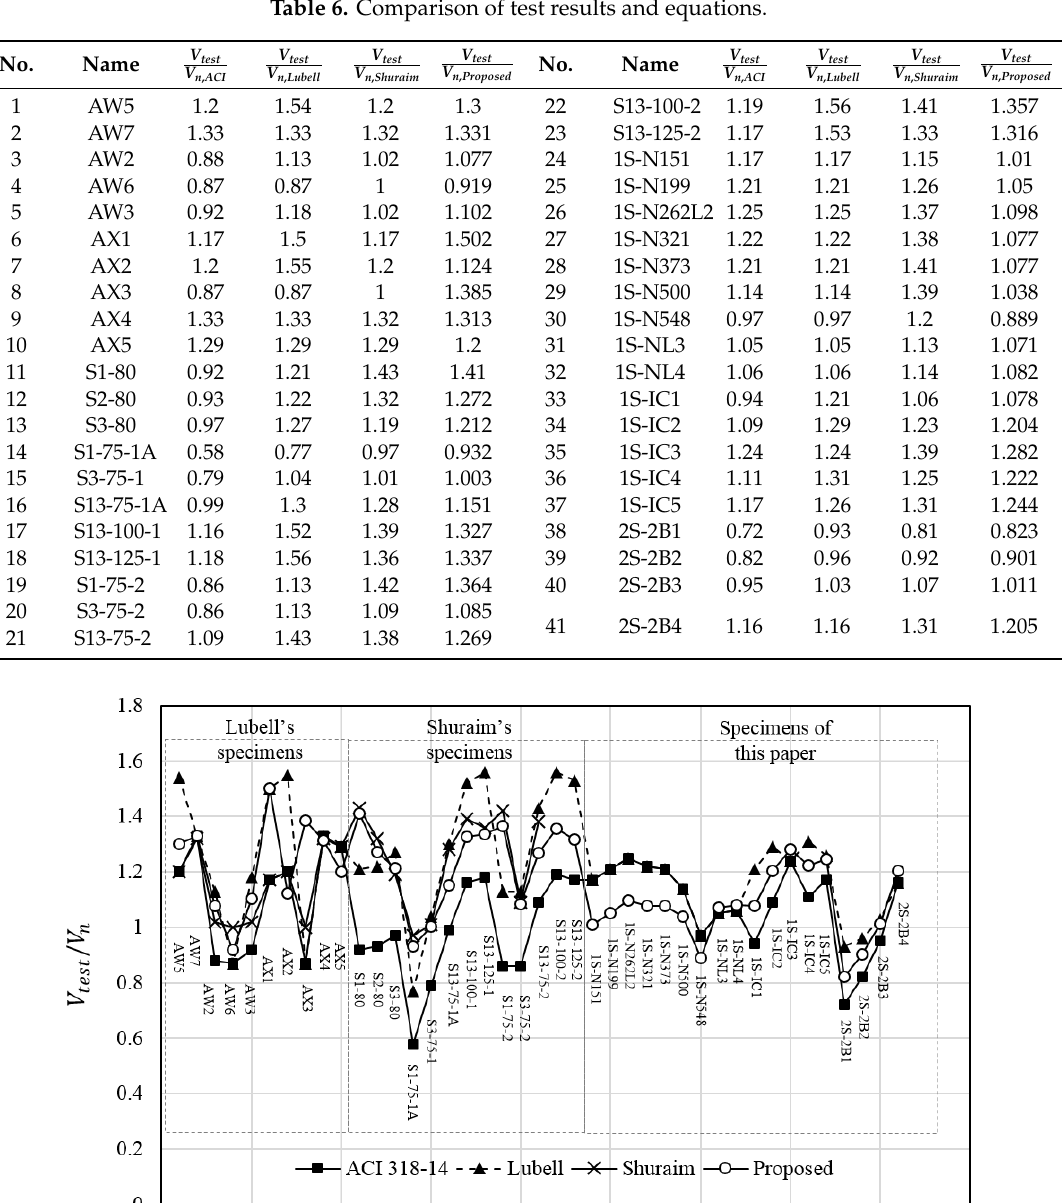
Figure 9. Comparison of shear equations with test results. Table 7. Comparison of shear equation’s accuracy.